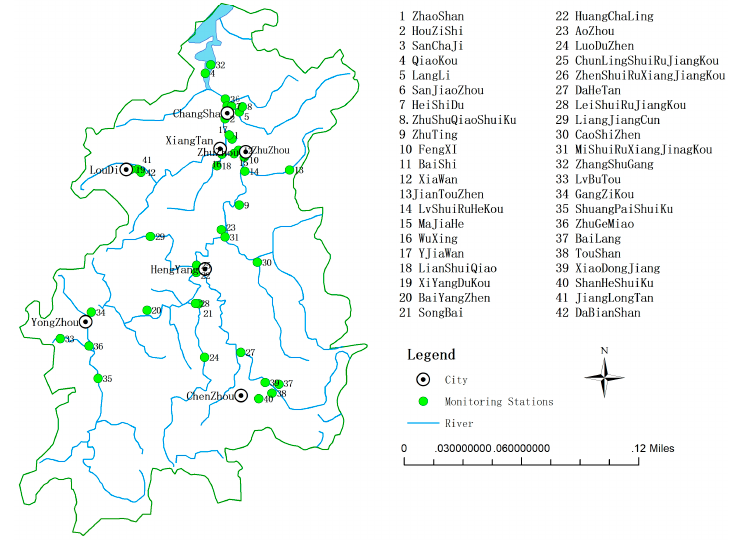
Figure 1. Location of environmental monitoring stations in the Xiangjiang river basin.